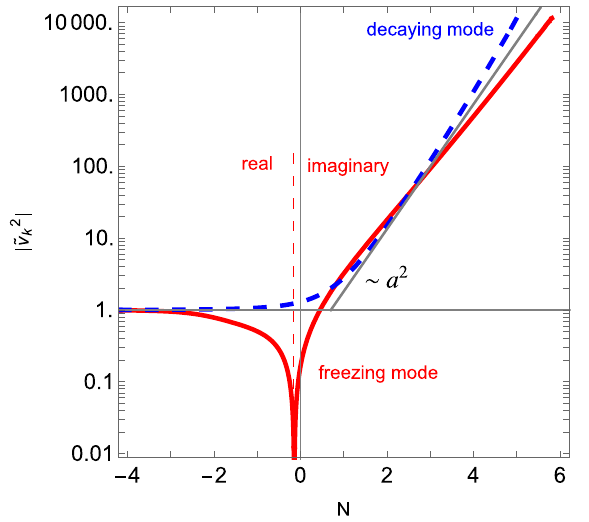
Fig. 6 Numericalcalculationsinsingle-fieldeffectivetheoriesforlight entropy perturbations; model described in Sect. 5.4. Left panel: evolu- tion of the sound speed given by Eq. (6) for initial conditions leading to a freezing adiabatic mode (red solid line) and for initial conditions leadingtoadecayingadiabaticmode(bluedashedlines);changeofsign of the sound speed squared, i.e. transition from real to imaginary sound